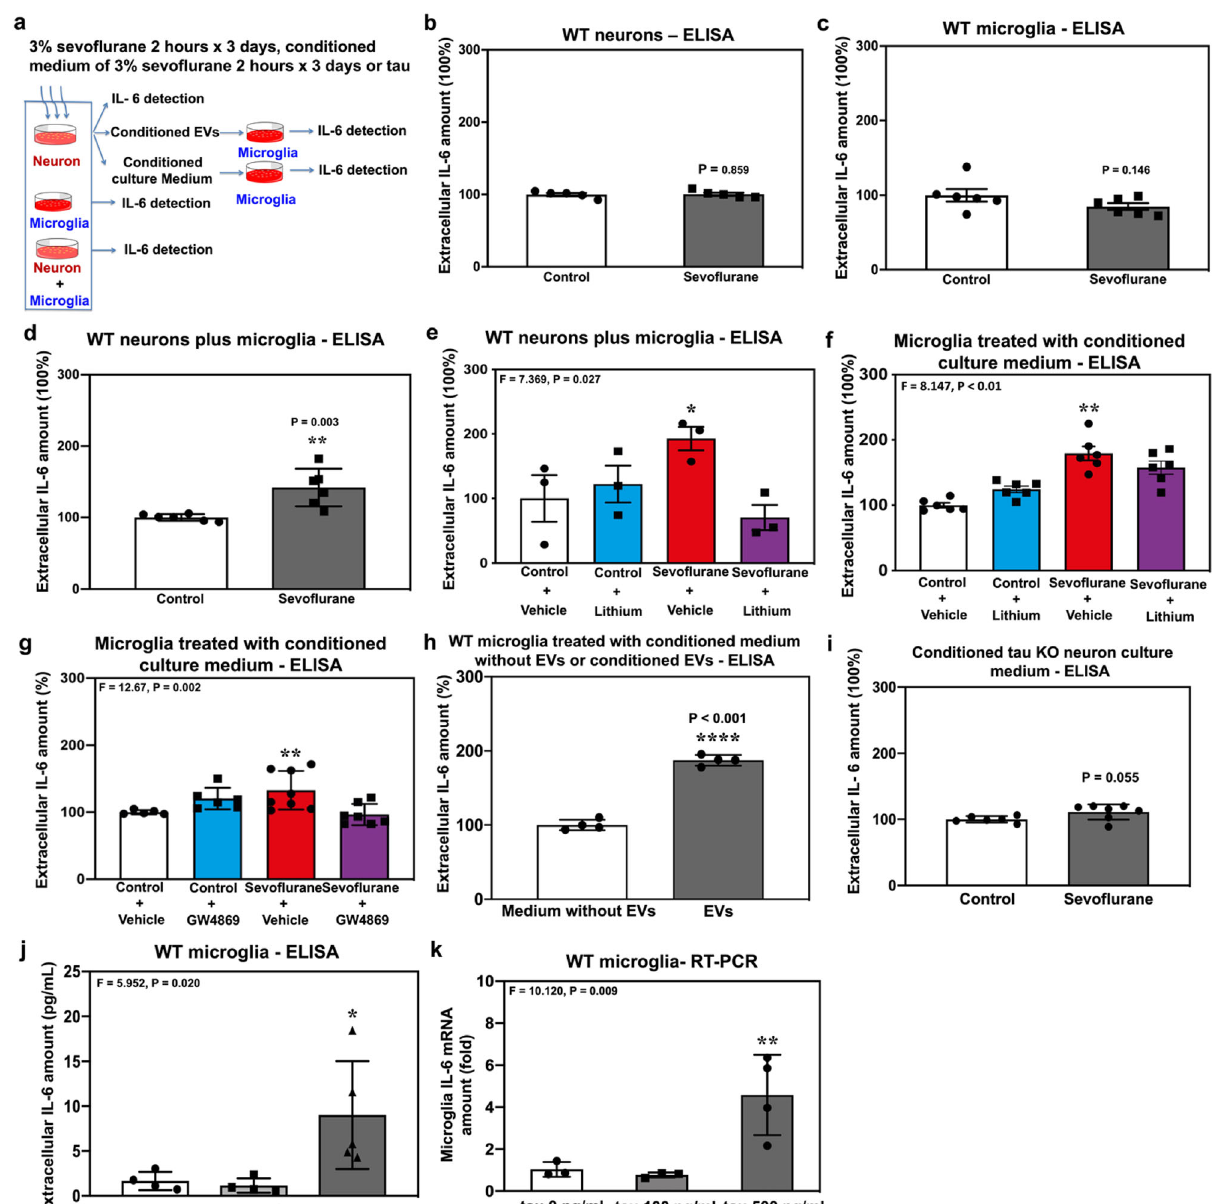
Fig. 6 Sevo fl urane increased extracellular IL-6 amounts in the culture medium of neurons plus microglia. a Experimental design. b Extracellular IL-6 amounts in the WT neuron culture medium. c Extracellular IL-6 amounts in the WT microglia culture medium. d Extracellular IL-6 amounts in the culture medium of WT neurons plus WT microglia. e Extracellular IL-6 amounts in the culture medium of WT neurons plus WT microglia with and without lithium treatment. f Extracellular IL-6 amounts in the culture medium of WT microglia treated with sevo fl urane-conditioned neuron culture medium with and without lithium. g Extracellular IL-6 amounts in the culture medium of WT microglia treated with sevo fl urane-conditioned neuron culture medium with and without GW4869. h Comparison of extracellular IL-6 amounts in the culture medium of WT microglia treated with the conditioned EVs speci fi cally extracted from the conditioned medium versus the same conditioned medium without those extracted EVs. i Effects of sevo fl urane conditioned tau KO neuron culture medium on extracellular IL-6 amount of microglia. j Extracellular IL-6 amounts in WT microglia treated with tau protein. k IL-6 mRNA expression in WT microglia treated with tau protein. N = 3 to 8 biologically independent samples in each group as demonstrated in each panel of the fi gure. Two-way ANOVA and post-hoc analysis with Bonferroni were used to analyze the data in Fig. 6e – g, the P values refer to the interaction of group (control condition and sevo fl urane) and treatment (vehicle versus lithium or GW4869) on IL-6 amounts. One-way ANOVA was used to analyze the data in Fig. 6j, k, the P values of one-way ANOVA and the post-hoc analysis with Bonferroni refer to the difference in IL-6 amounts from 0, 100, and 500 pg/ml of tau. Student ’ s t test was used to analyze the data in Fig. 6b, c, d, h, i, the P values refer to the difference in IL-6 amounts between the control condition versus sevo fl urane. * P < 0.05, ** P < 0.01, **** P < 0.001. Error bar indicates standard deviation. P-tau phosphorylated tau, KO knockout, EVs extracellular vesicles, WT